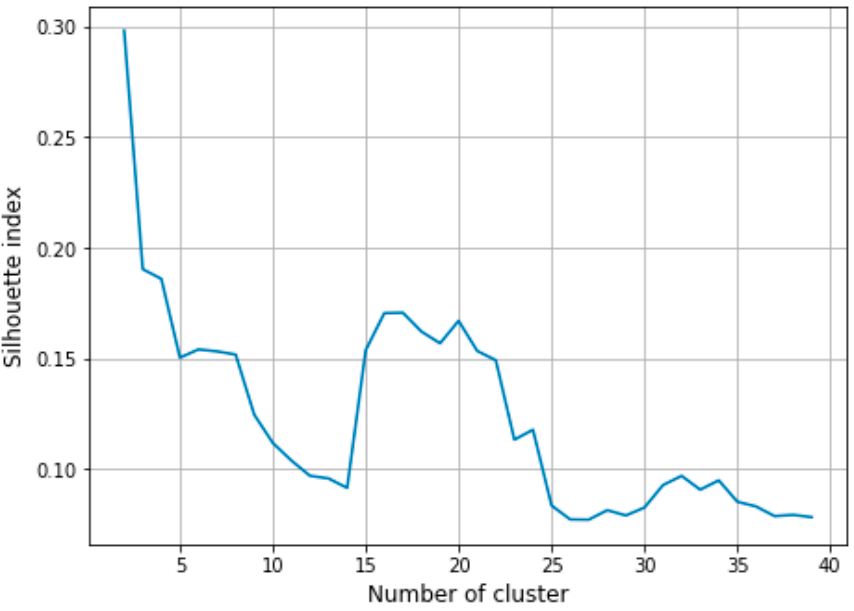
Figure 2. Choice of the optimal number of clusters.